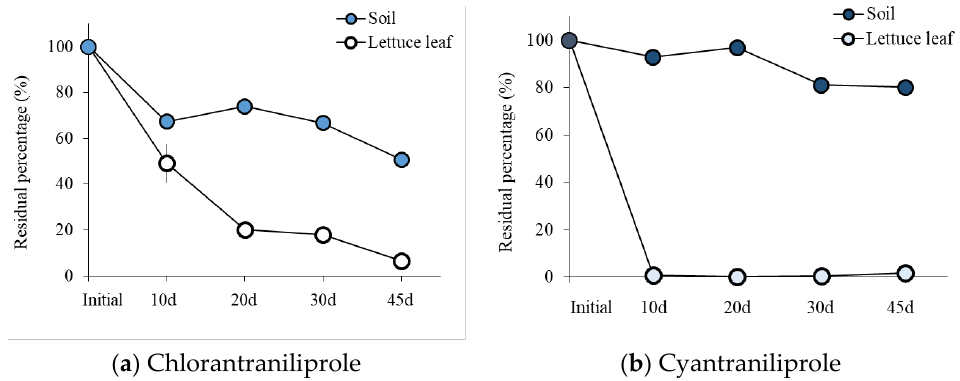
Figure 5. Estimate of amounts of residual pesticides in soil and lettuce leaves from indoor crops over a 45-day culture experiment (N = 3).